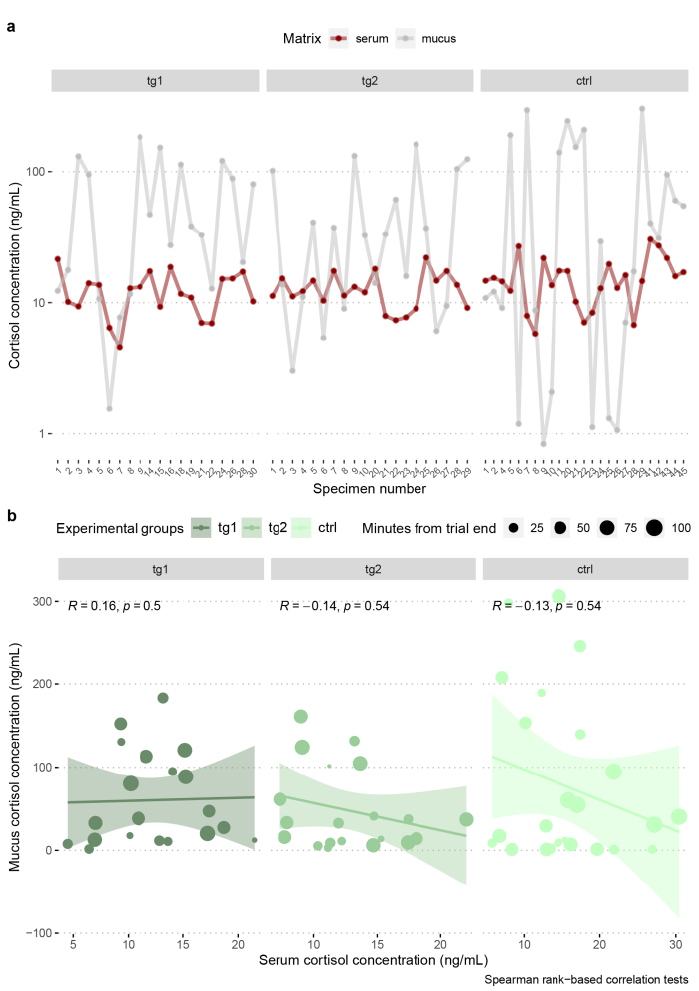
Figure 4. Comparison of A. anguilla blood serum–skin mucus cortisol concentrations ( a ), and correlation tests between matrices ( b ) per experimental group, with indication of the time, in minutes, elapsed from the end of trial to sampling operations, and details of the statistical tests. Colors indicate experimental groups.